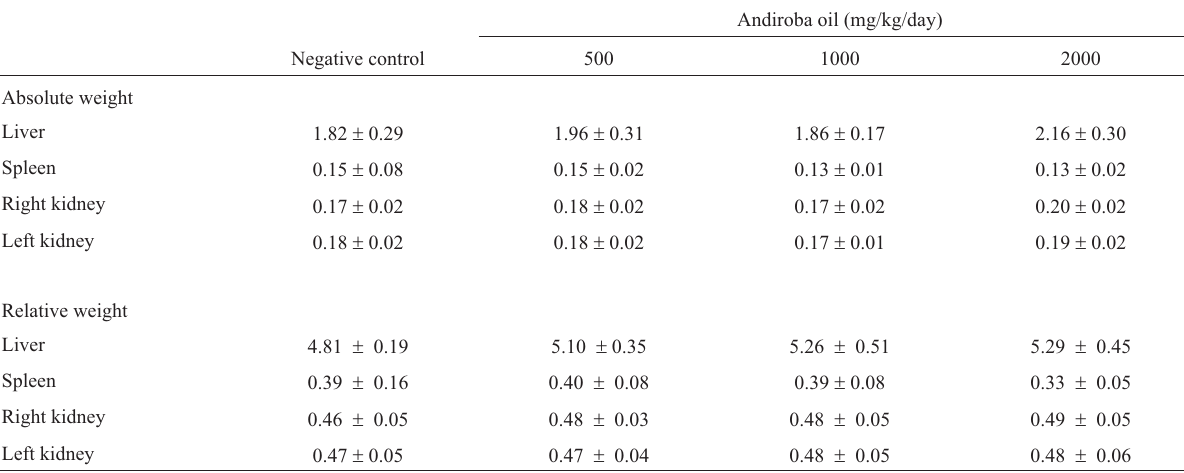
Table 3 - Absolute and relative weights of mouse organs after treatment with andiroba